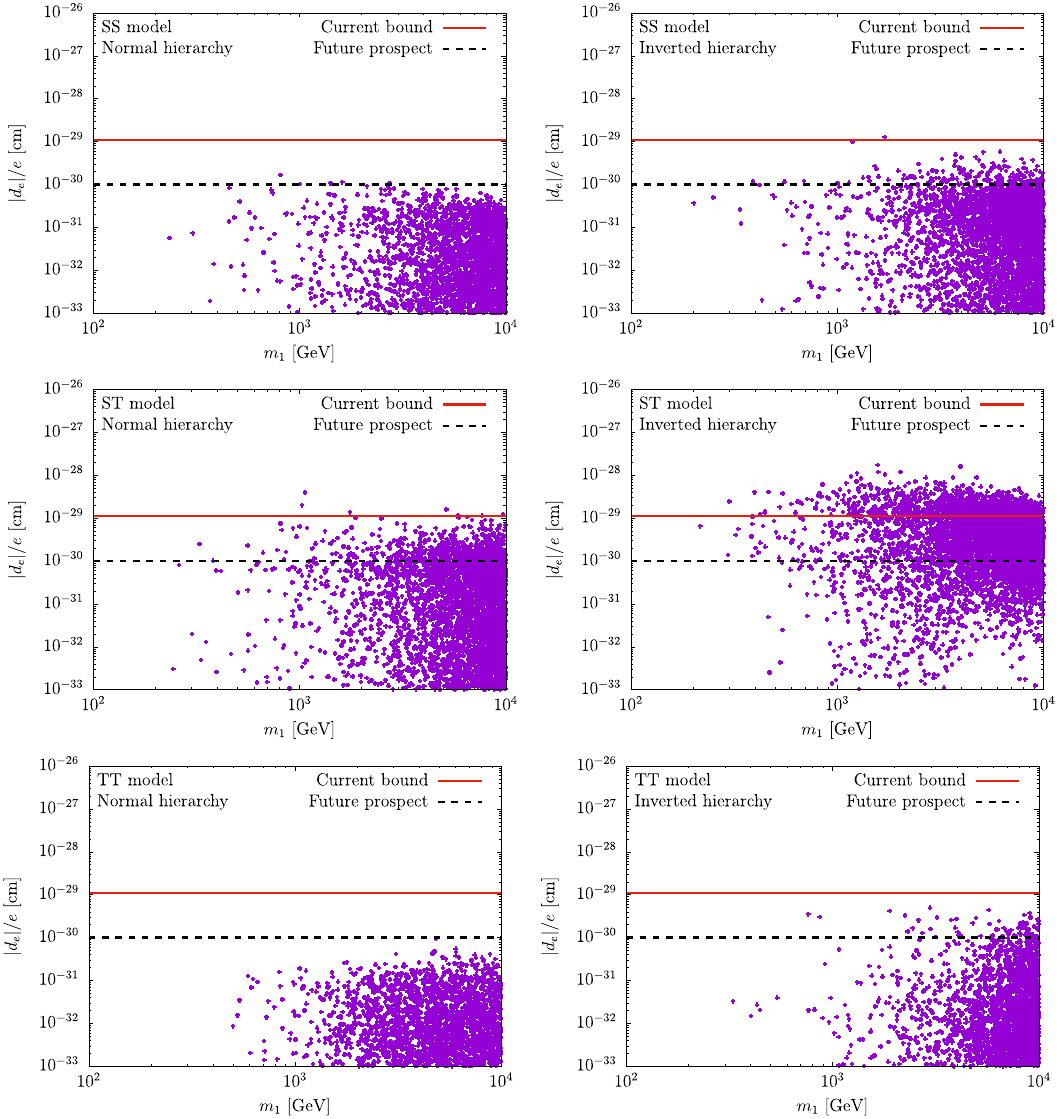
Figure 9 . Predicted electron EDM with the parameters accommodating neutrino oscillation data and charged LFV constraints. The solid red and the dashed black lines represent the current experimental bound of the ACME Collaboration [19] and the future sensitivity [20, 21],